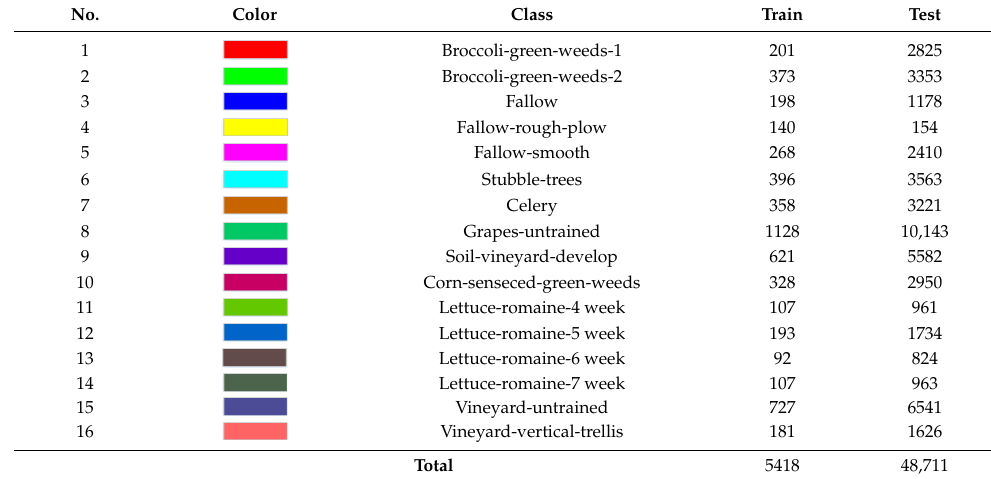
Table 3. The information of SA dataset, including number of training and test samples. No.